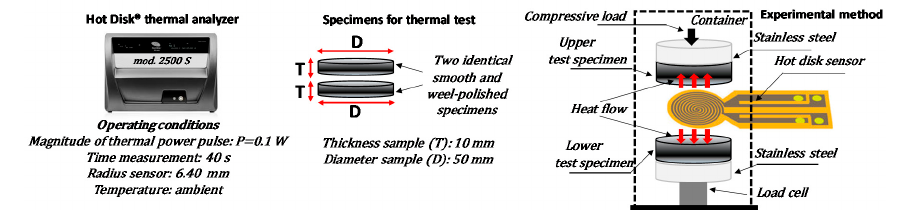
Figure 8. Schematic representation of thermal conductivity measurements. From left to right: Hot Disk ® thermal constants analyzer ( left ), specimens for thermal test ( center ) and schematic representation of a TPS sensor used for the measurements of thermal conductivity ( right ).